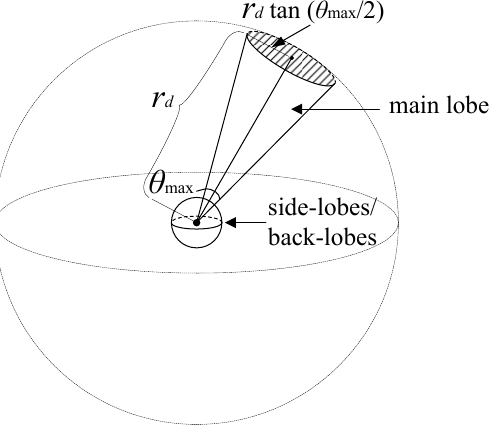
Figure 10. Approximated radiation pattern of a directional